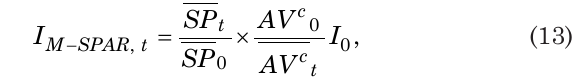
Table 5. Correlations of monthly house price index changes, 199–2009 Cities Standard